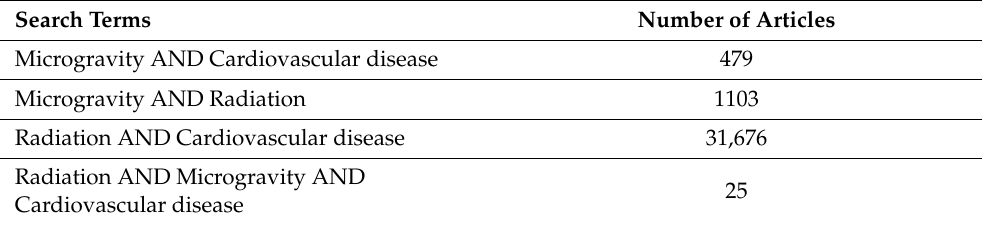
Table 2. Number of articles found according key words (in PubMed on 3 October